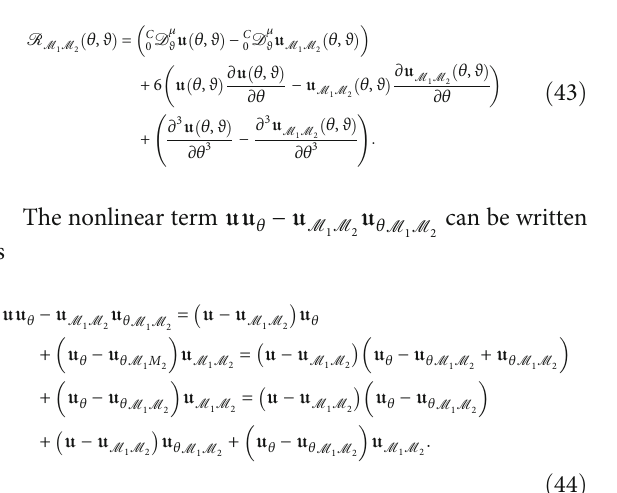
Figure 2: (a) Exact solution, (b) approximate solution, and (c) absolute error function for k